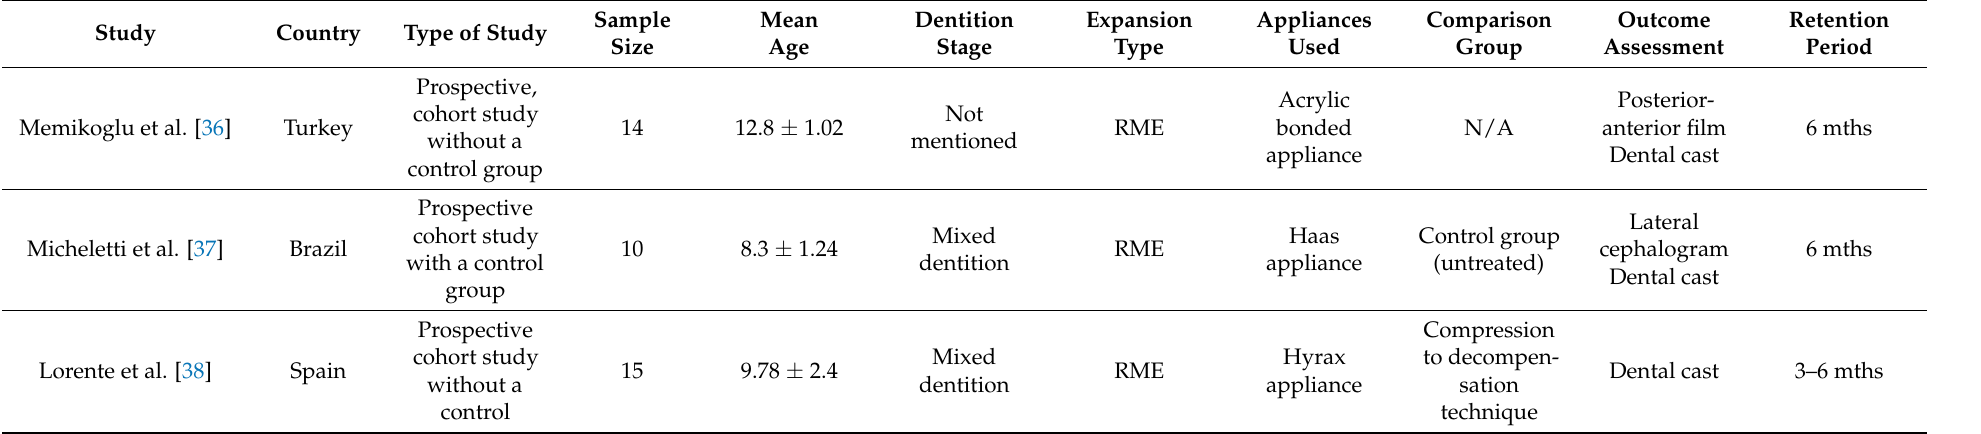
Table 1. Characteristics of included